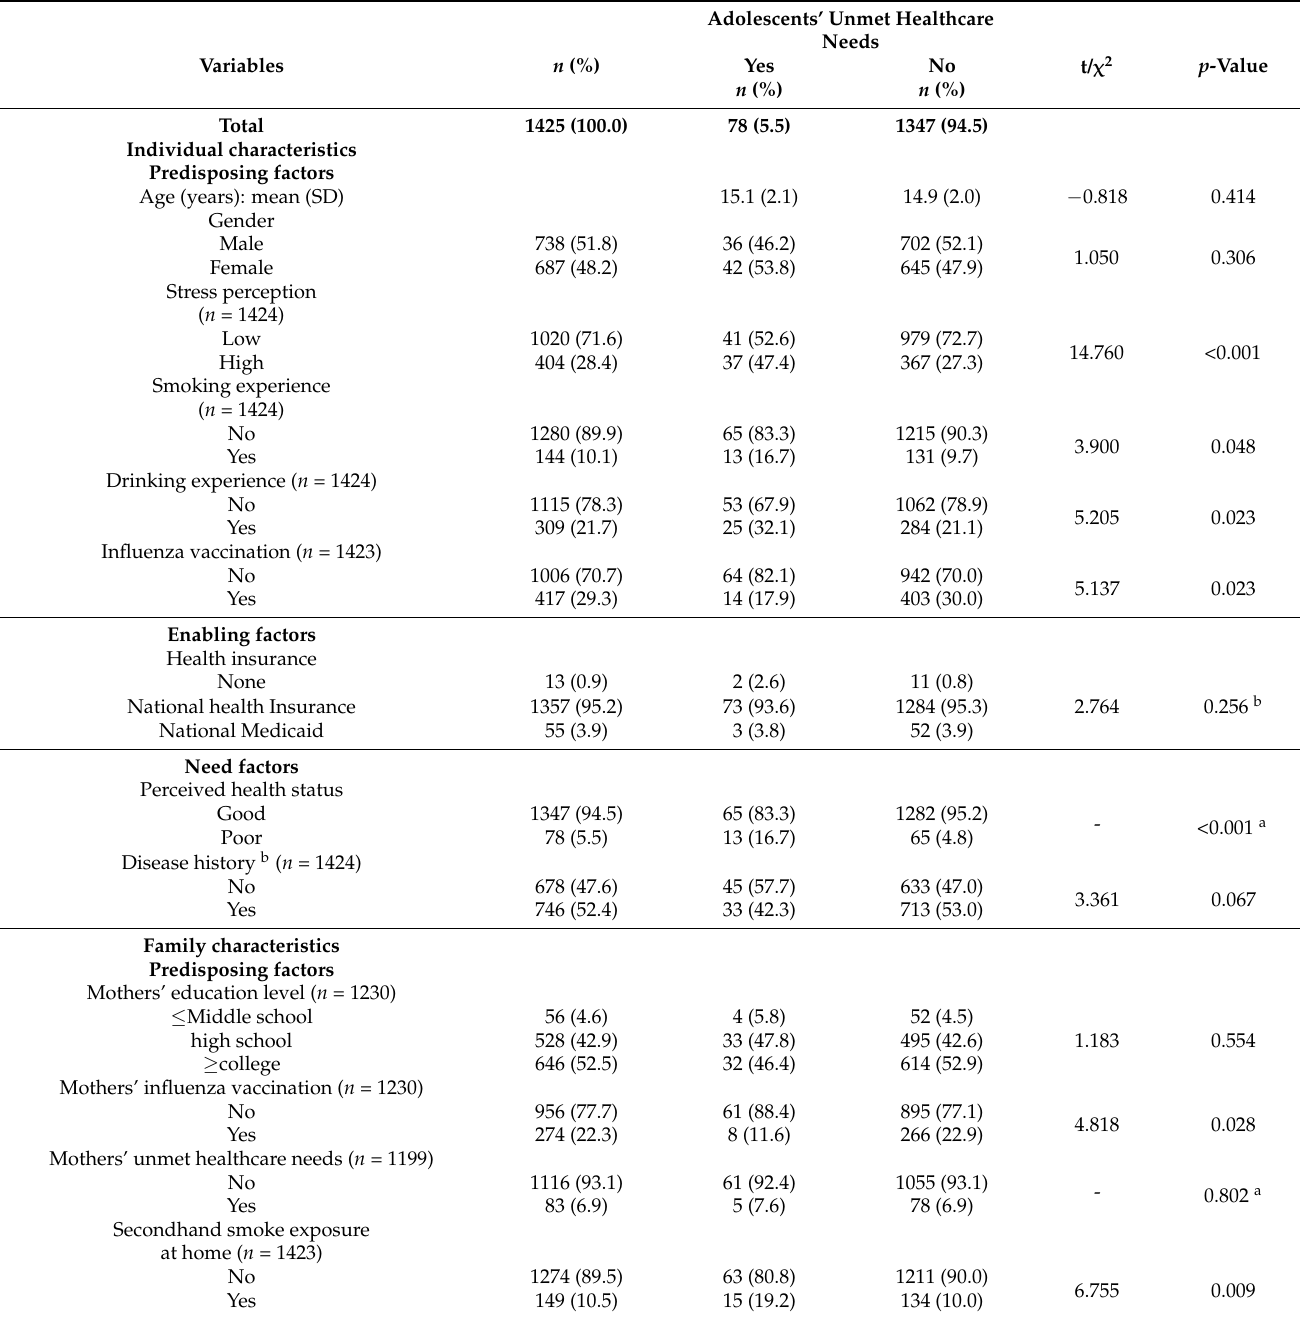
Table 1. Differences of main variables based on Andersen’s Behavioral Model according to experience of unmet healthcare needs ( n =